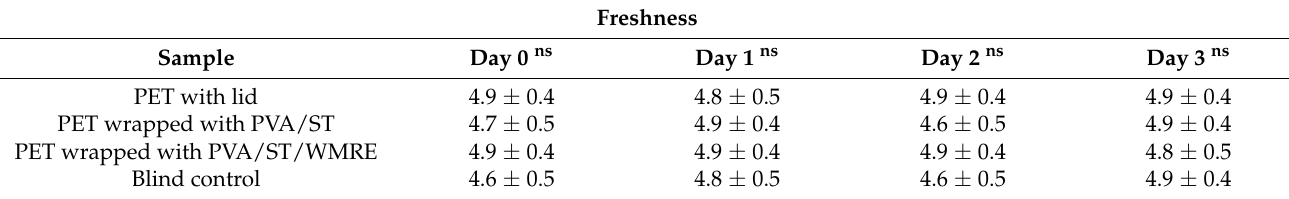
Table 4. The quality assessment on freshness of fresh-cut purple cabbage.